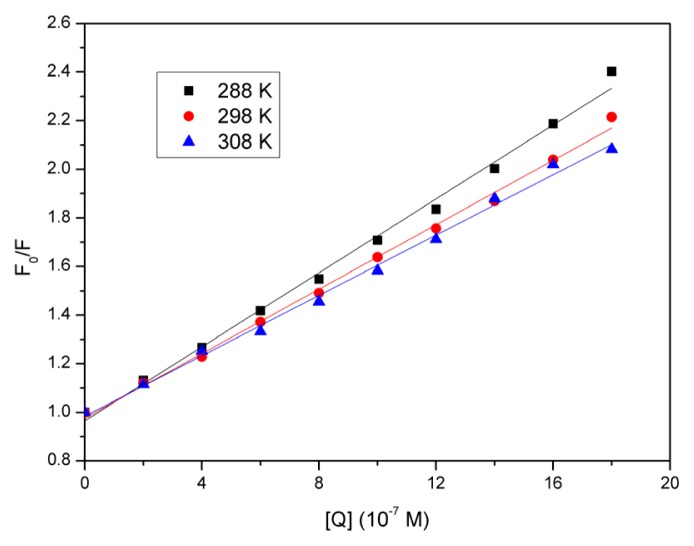
Stern-Volmer plots for quenching of BSA fluorescence by eupatorin at different temperatures (288 K, 298 K and 308 K). CBSA = 3.0 × 10−7 M; pH 7.4; λex = 280 nm, λem = 290–500 nm.